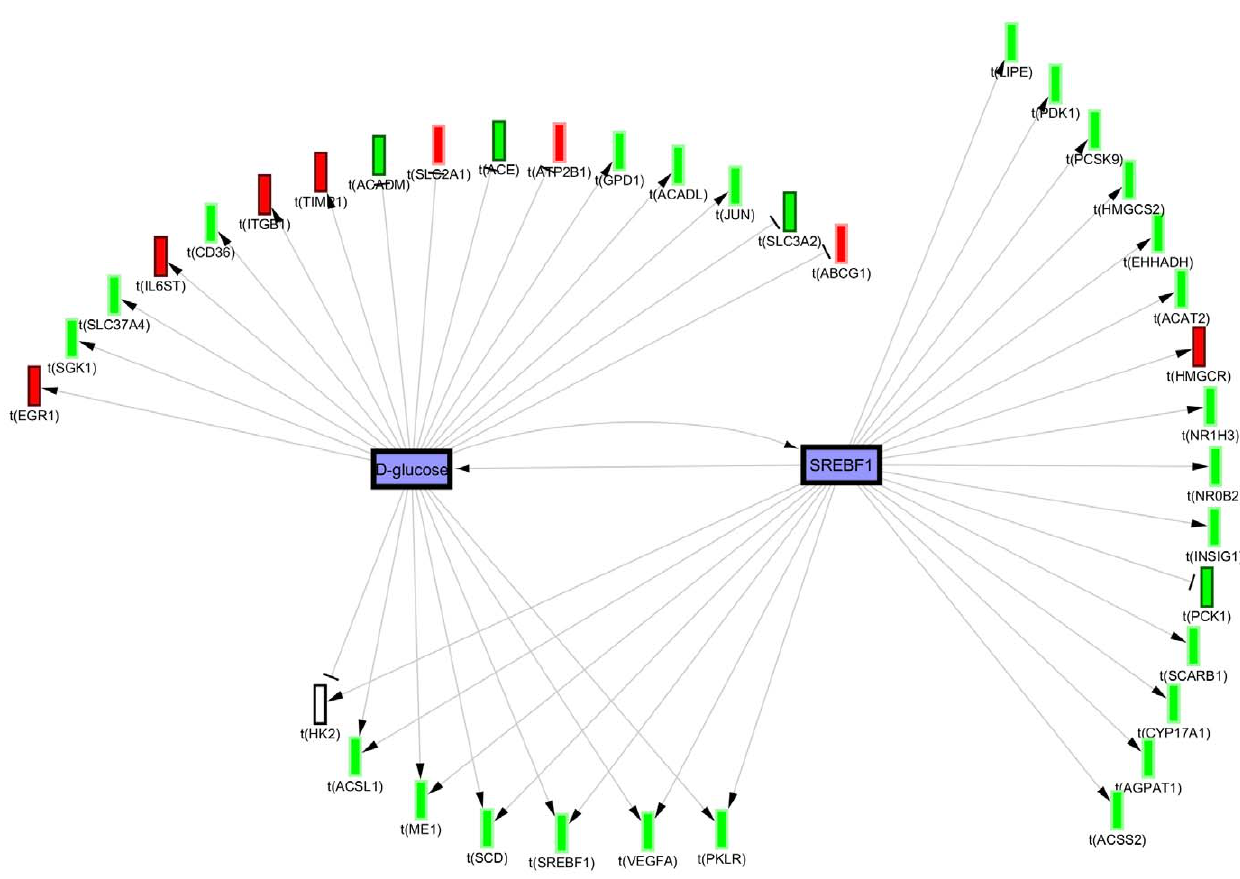
Figure 5. Merged causal graph showing potential positive reinforcing interactions between glucose- and SREBF1- supported by evidence from studies on its role in mediating hyperlipidemia in response to high fat diet [ 27 ] . (Blue nodes = predicted decrease, Red nodes = observed mRNA decrease, Green nodes = observed mRNA increase).